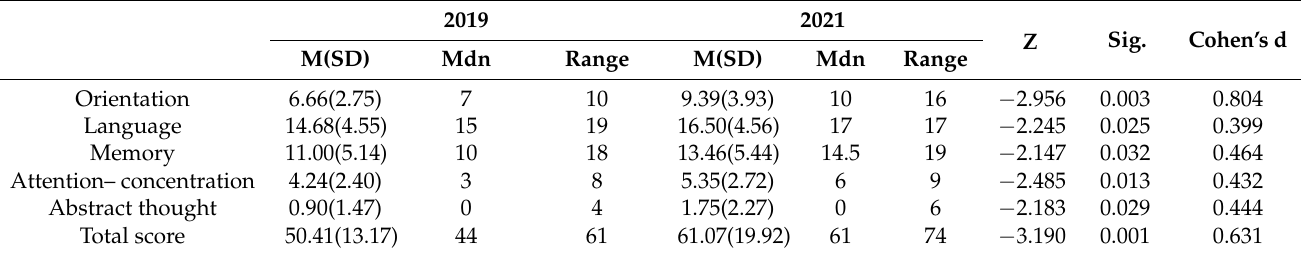
Table 4. Serious–severe group ( n = 31) 2019–2021. Wilcoxon Z Range test for related